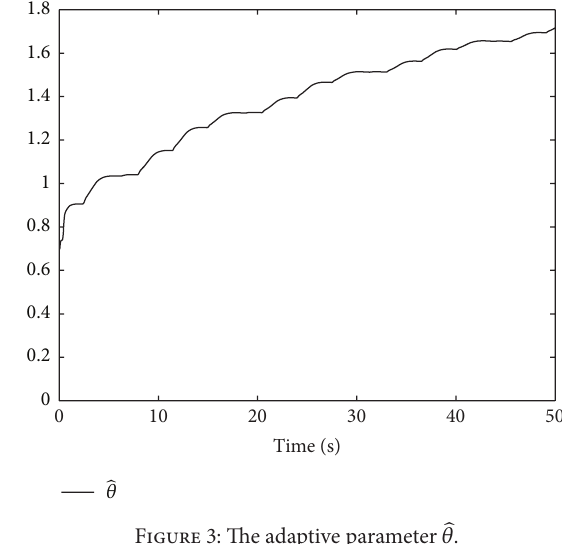
Figure 3: The adaptive parameter